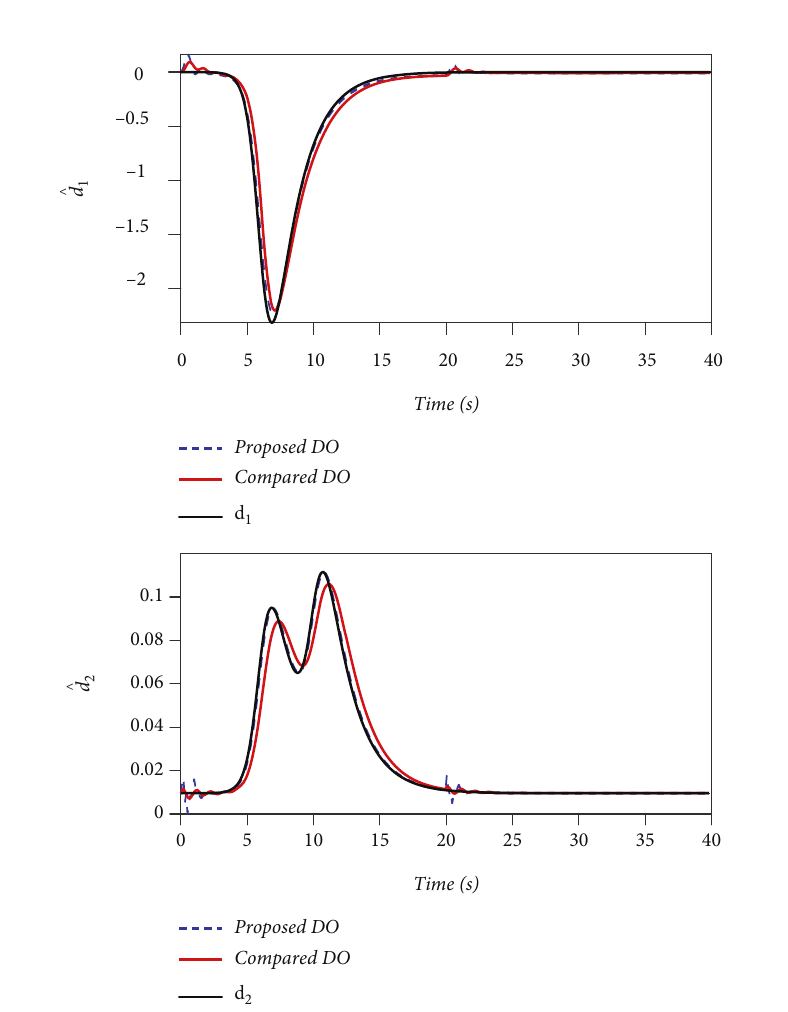
Figure 7: Estimation of d